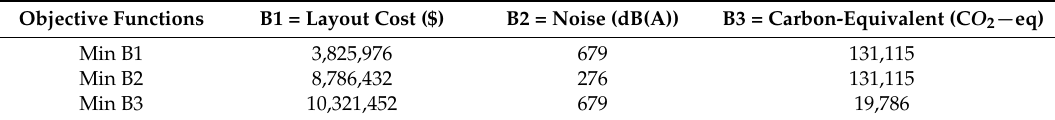
Figure 11. ( A ) Pareto curve highlighting the trade-off between noise minimisation and carbon-equivalent emission minimisation; ( B ) Pareto curve highlighting the trade-off between noise minimisation and layout cost minimisation; ( C ) Pareto curve highlighting the trade-off between layout cost minimisation and carbon-equivalent emission minimisation. Table 5. Payoff table between all objective functions considered.